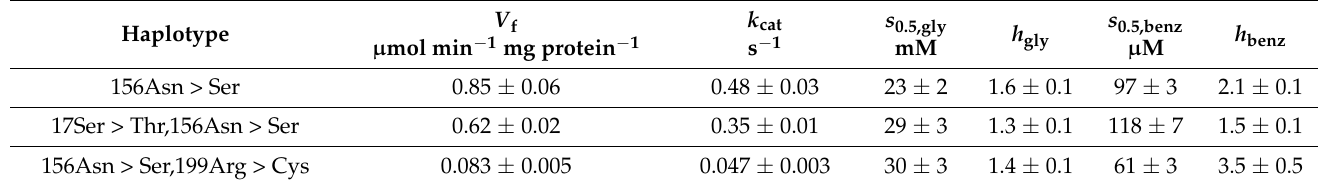
Table 3. Enzyme–kinetic parameters of the GLYAT